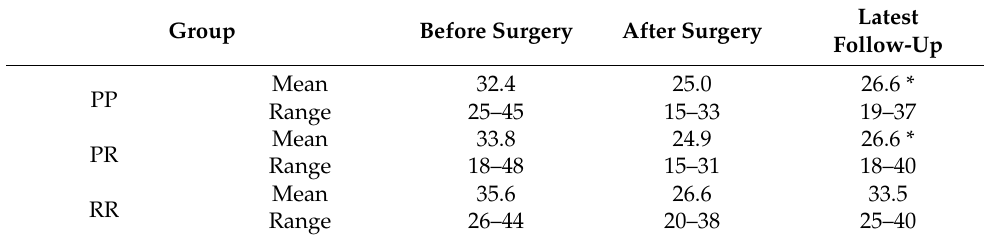
Table 5. Mean M1M5 angle in the three